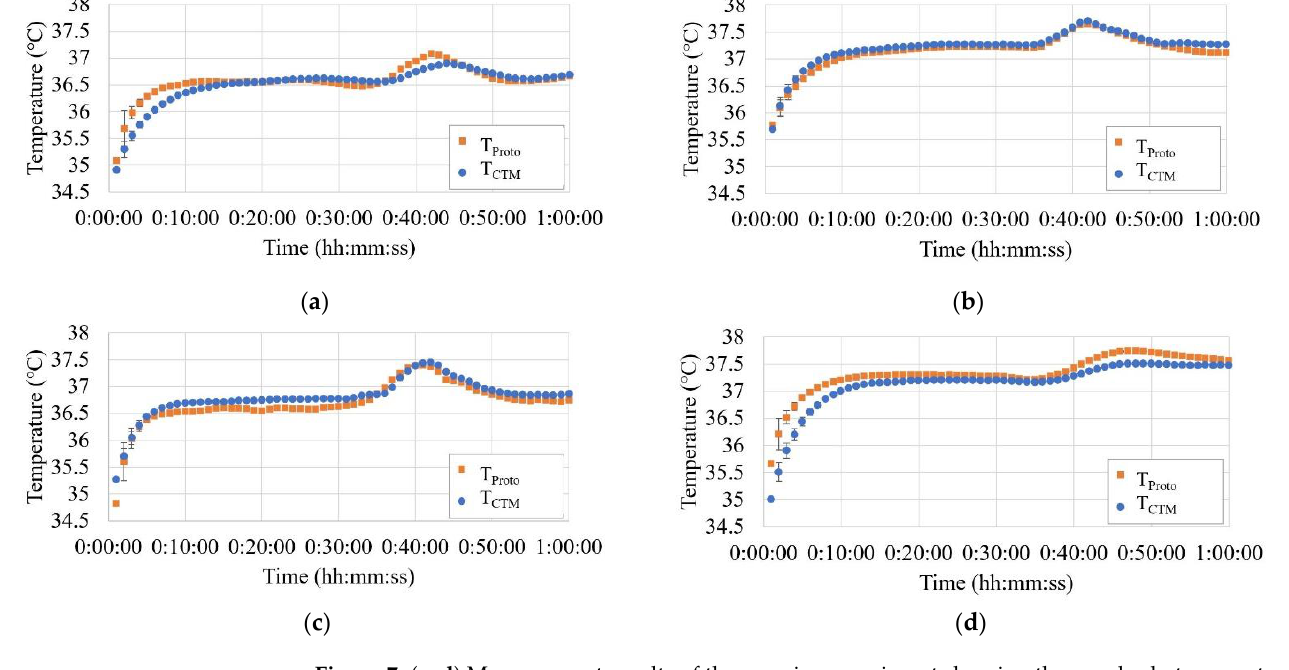
Figure 7. ( a – d ) Measurement results of the exercise experiment showing the core body temperature change of the four subjects (one minute average and SD).